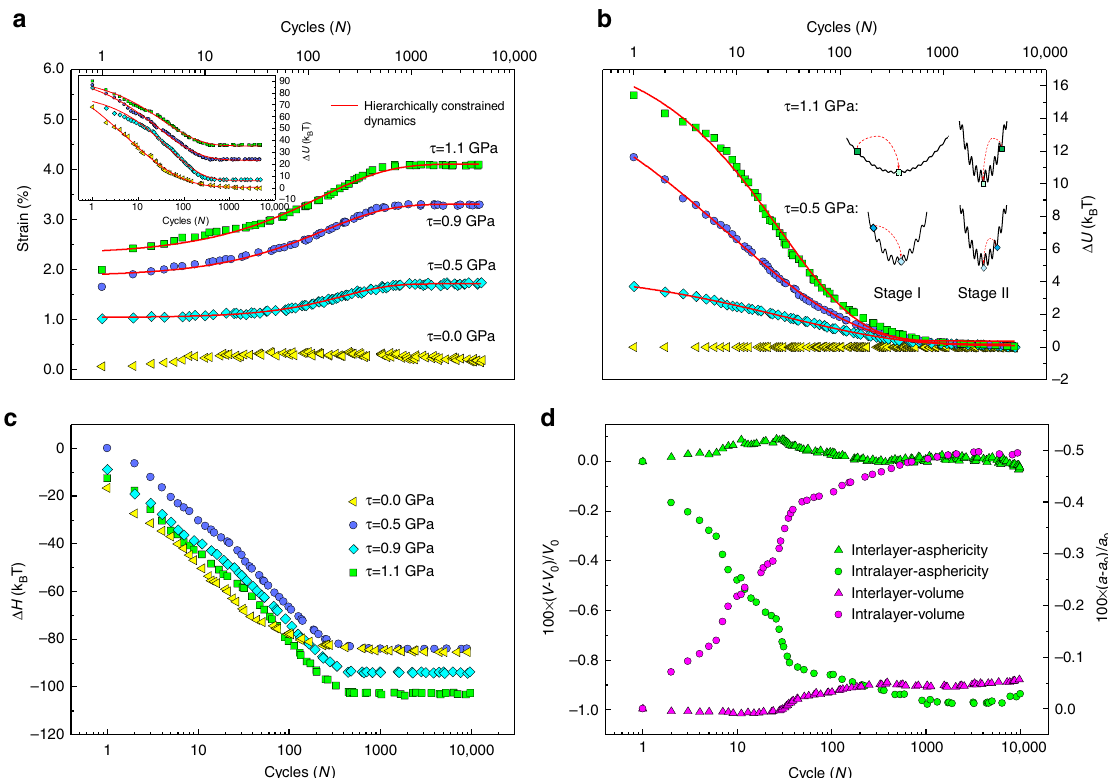
Fig. 2 Evolution of the system under constant mean shear stress as a function of cyclic perturbations. a Strain evolution as cycling progresses for different stress levels. The inset shows the drop in potential energy level during the process. For the case where stress is zero, the strain remains constant, while the energy drops regardless. Such behavior is akin to relaxation phenomena in glasses and can be explained via hierarchically constrained dynamics with stretched exponential behavior. b The drop in potential energy during the unloading phase. We observe an exponential relaxation reminiscent of viscoelastic deformation in solids. c The decrease in the enthalpy as a function of cycles during the relaxation stage. This indicates that the enthalpy as well as internal energy is minimized in these relaxation processes. d The change in average Voronoi volume and asphericity of the atoms in the interlayer and intralayer of the specimens. We observe a signi fi cant decrease in characteristics of the Voronoi cell for atoms in the interlayer, while the intralayer attributes remain approximately constant. This highlights the recon fi guration of interlayer constituents as the primary contributor to the relaxation phenomenon at the